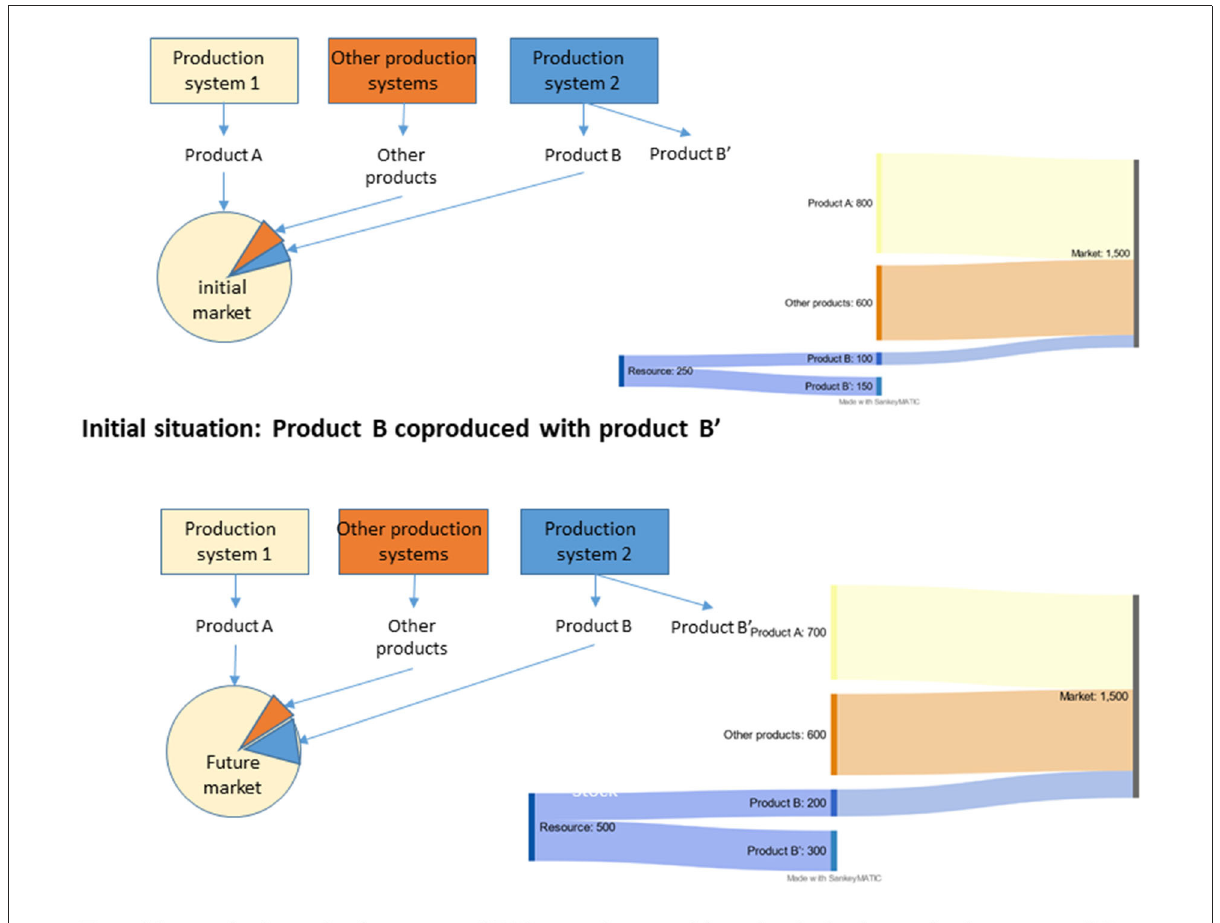
FIGURE2 MFA and upstream changes in flows according to multi-output